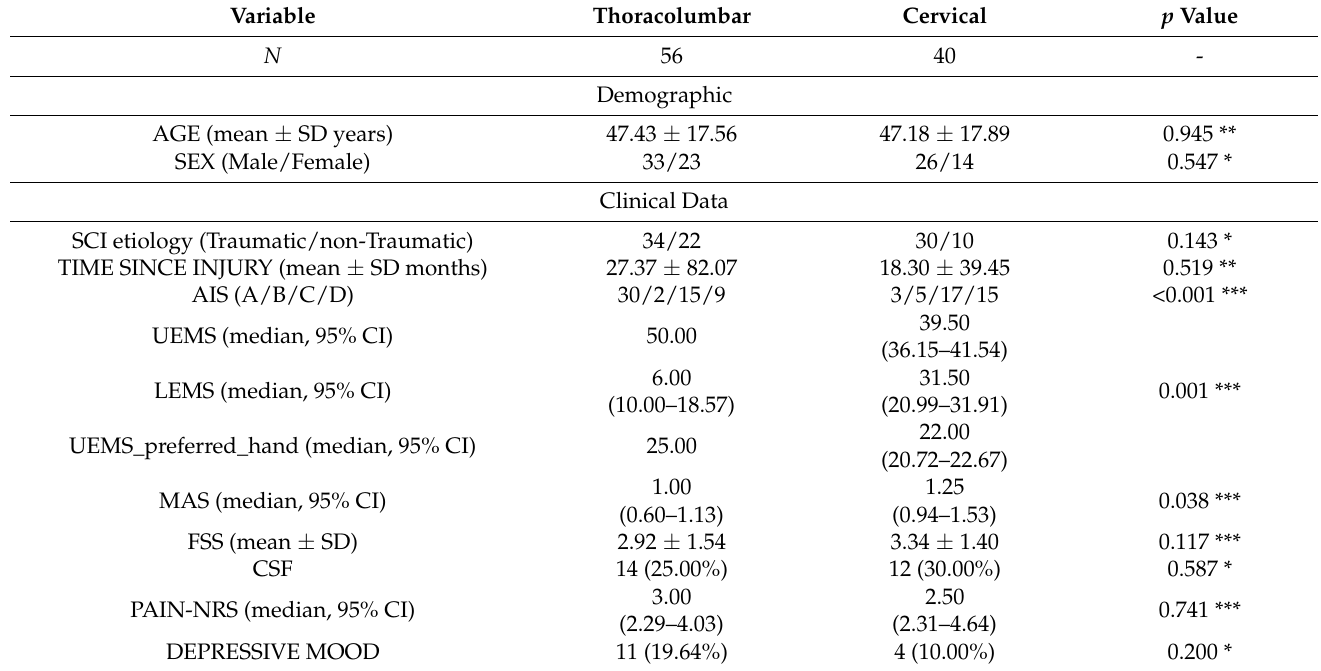
Table 1. Demographic characteristics of spinal cord injury participants according to the lesion level: cervical or